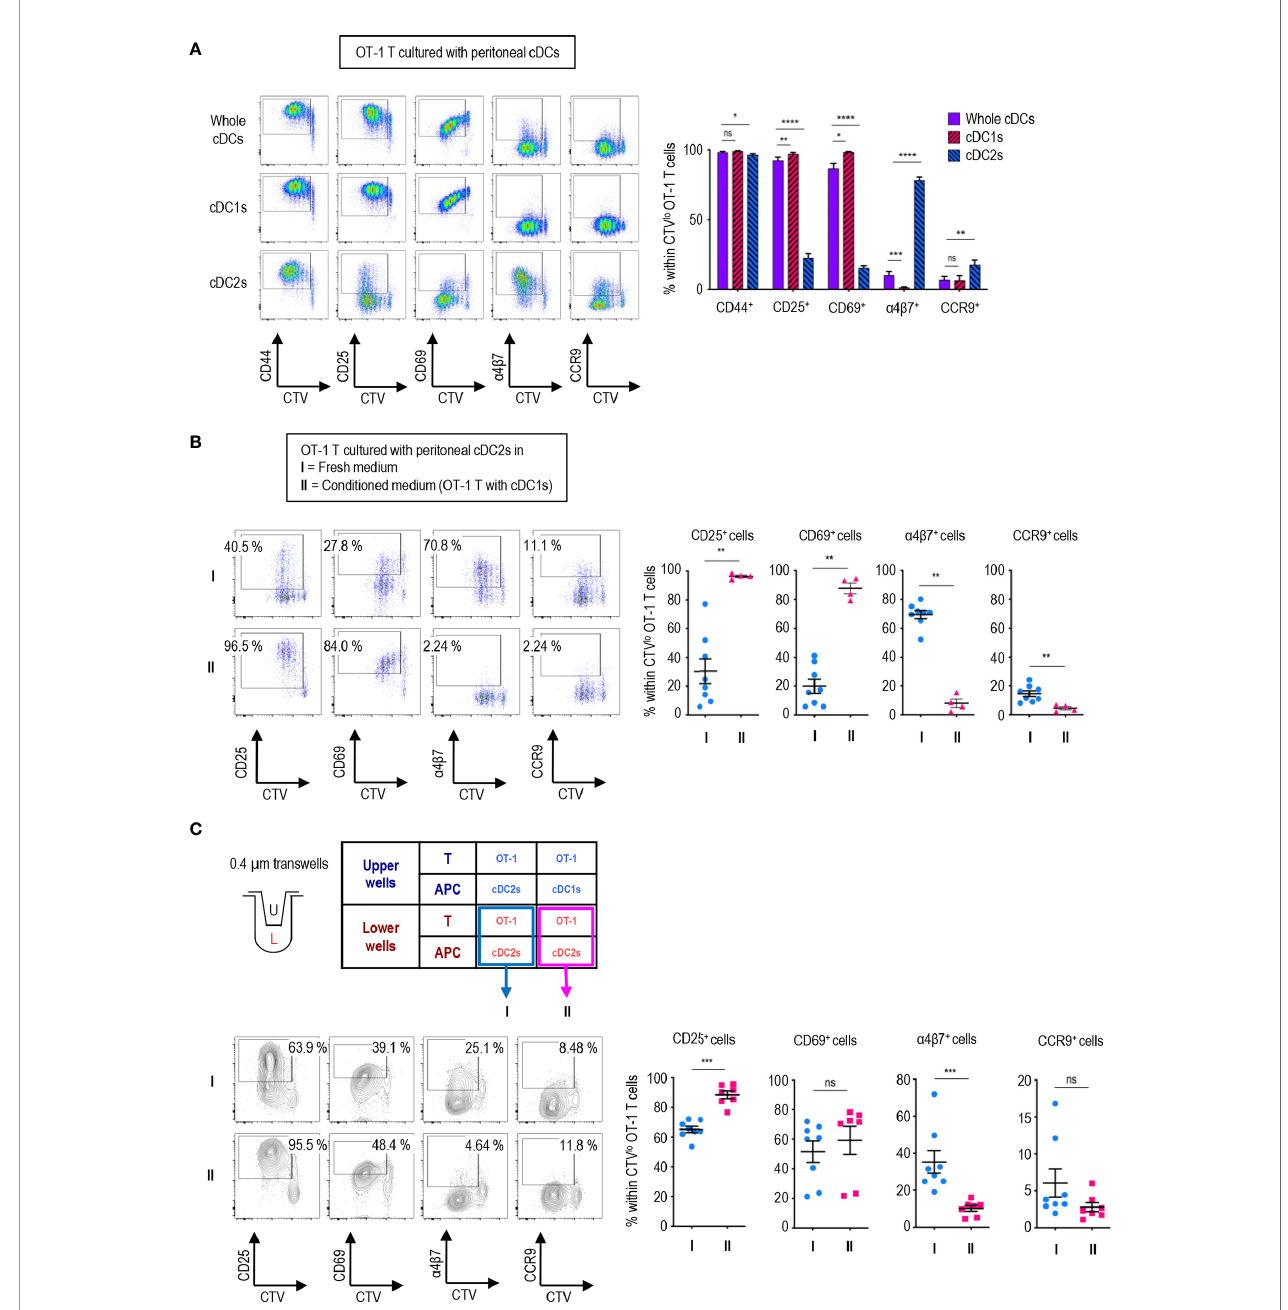
FIGURE 2 | Peritoneal cDC1s play a dominant role in regulating CD8 T cell responses via soluble mediators. An hour after injecting 1.5 mg of OVA (Grade V) i.p., OVA-laden peritoneal cDCs were isolated and co-cultured with naïve OT-1 T cells in the ratio of 1:10 (APC:T). OT-1 T cells were analyzed on day 3. (A) Expression of CD44, CD25, CD69, a 4 b 7, and CCR9 molecules on OT-1 T cells stimulated by peritoneal whole cDCs and cDC subsets. Live CD8 + cells are plotted and the percentages of cells expressing each molecule among CTV lo proliferated OT-1 T cells are shown in a graph. Data are pooled from 7 independent experiments (n ≥ 7). (B) OT-1 T cells differentiated by peritoneal cDC2s in conditioned medium. Conditioned medium contained fresh complete medium and the supernatant from co-culture of cDC1s and OT-1 T cells in a 2:3 ratio. OVA-laden peritoneal cDC2s and OT-1 T cells were cultured under either fresh complete medium (I, control) or conditioned medium (II). Live CD8 + T cells are plotted and the percentages of cells expressing each surface molecules are shown in graphs. Data are pooled from 2 independent experiments (n ≥ 4). (C) OT-1 T cells differentiated in 0.4 µm pore transwells. OT-1 T cells and peritoneal cDCs were co-cultured in transwells for 3 days in combinations as shown in the table. T cells in the lower chamber were analyzed for the expression of CD25, CD69, a 4 b 7, and CCR9. Live CD8 + T cells are plotted and the percentages of cells expressing each molecule among CTV lo proliferated OT-1 T cells are shown in graphs. Data are pooled from more than 2 independent experiments (n ≥ 7). Error bars (A – C) indicate mean ± SEM. *p<0.05; **p<0.01; ***p<0.001; ****p<0.0001; ns, statistically not signi fi